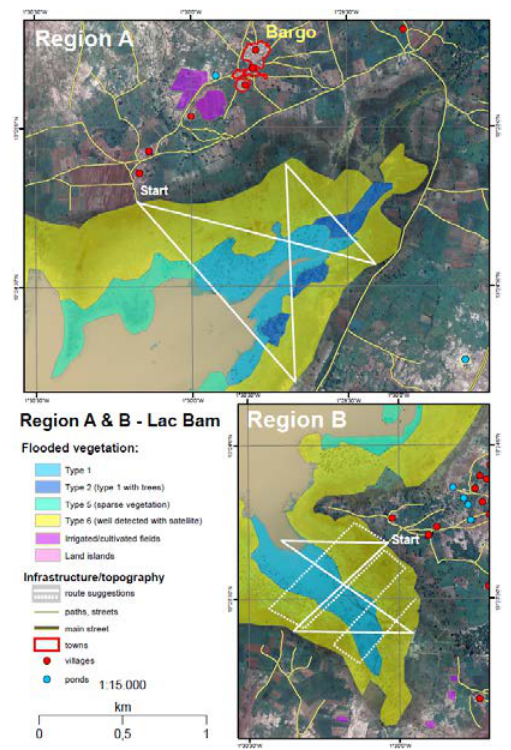
Figure 1. Map used for the field campaign in Region A and Region B which both feature flooded vegetation areas that are well classified (yellow) and not detected (blue), using dual- polarimetric TerraSAR-X or RADARSAT-2